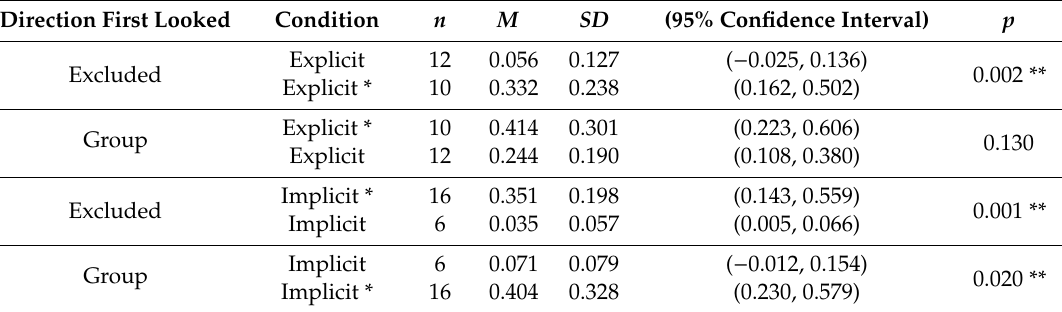
Table 3. Mean probabilities of looking from the neutral character to the excluded character or group. Direction First